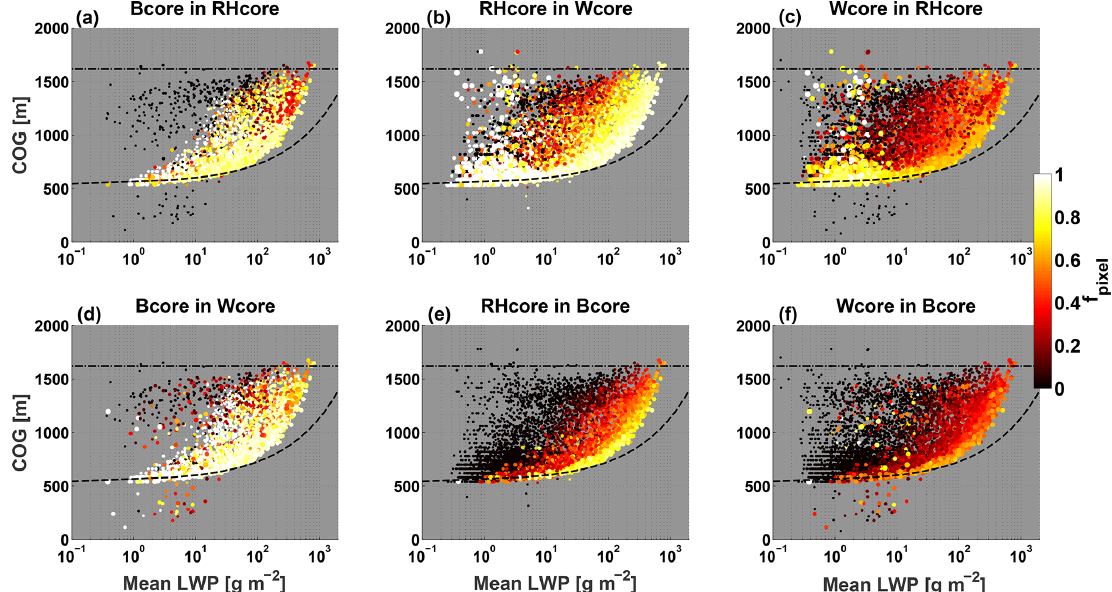
Figure 5. CvM phase-space diagrams of pixel fractions ( f pixel ) of each of the three cores within another core, including six different permutations (as indicated in the panel titles). Bright colors indicate high-pixel fractions (large overlap between two core types), while dark colors indicate low-pixel fractions (little overlap between two core types). Only clouds with a non-zero core fraction (for the core in question) are considered (e.g., for the B core in RH core in panel a , only clouds that contain at least one pixel with positive buoyancy are considered). Scatter point size is proportional to the minimum f vol of the core pairs in question.